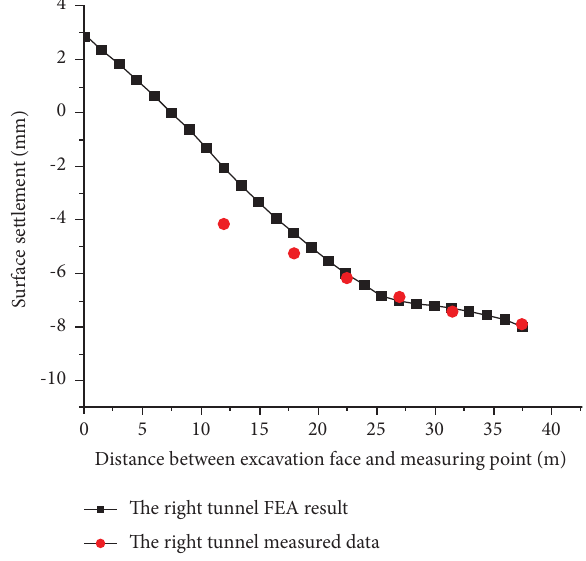
Figure 12: Comparative analysis of calculated value and moni- toring value (excavation gap filling).